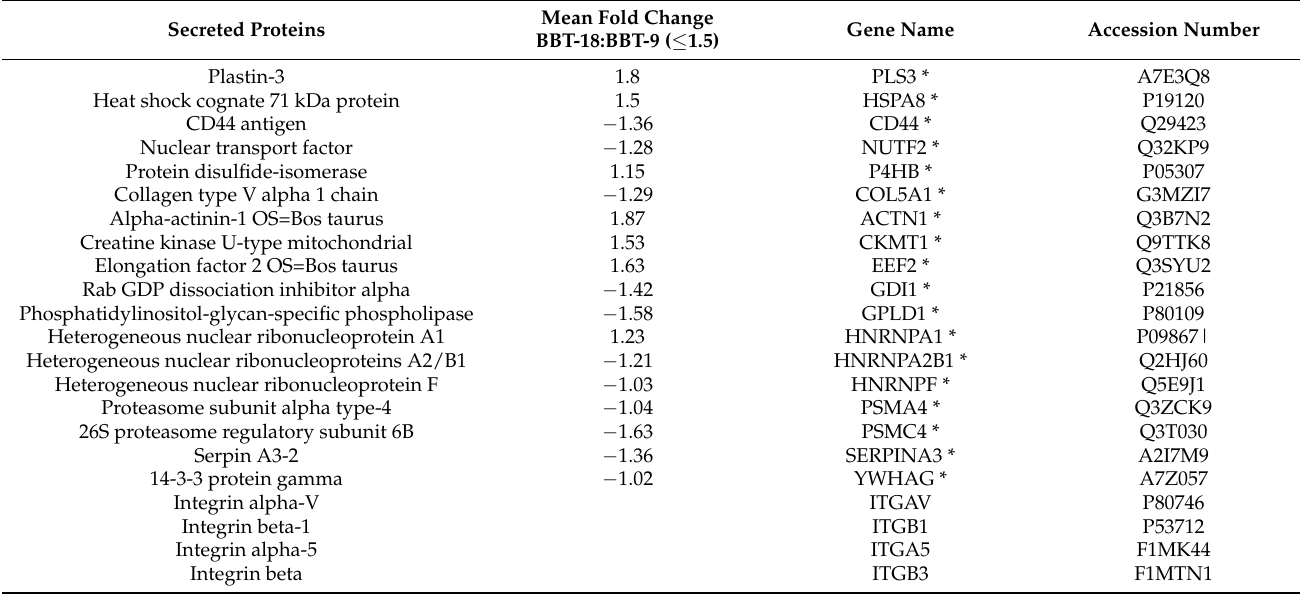
41 in EV fractions (Tables 1 and 2), and 21 soluble proteins (Table 3). BBT-18 and BBT-9 overrepresented 13 and 8 EPRP in the soluble fraction (Figure 3a) and 12 and 7 EPRP in EVs (Figure 4b), respectively. From the set of 41 EPRP proteins in EVs, we identified a group of 18 proteins corresponding to a day 16 conceptus, commonly expressed in BBT-18 and BBT-9 (Table 2). Table 2. Early pregnancy-related proteins coexpressed in BBT-18- and BBT-9-EV-cargo detected by iTRAQ-LC-MS/MS analysis. * Pregnancy-related proteins reported on in vivo day 16 conceptus in literature